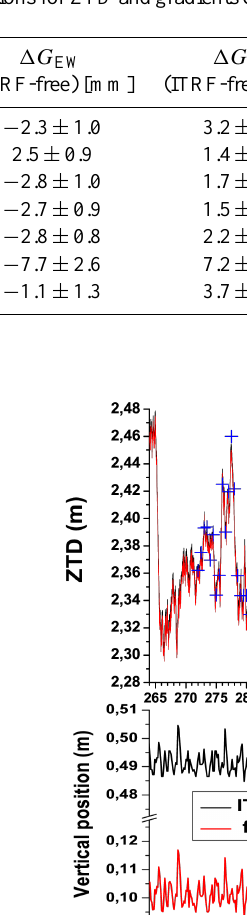
Table 2. Differences of tropospheric parameters between solutions in ITRF and relaxed reference frame (free) for the 6 stations shown in Fig. 4 and the 44 stations used in calculations. Biases and standard deviations for ZTD and gradients components ( G EW and G NS ) are shown.